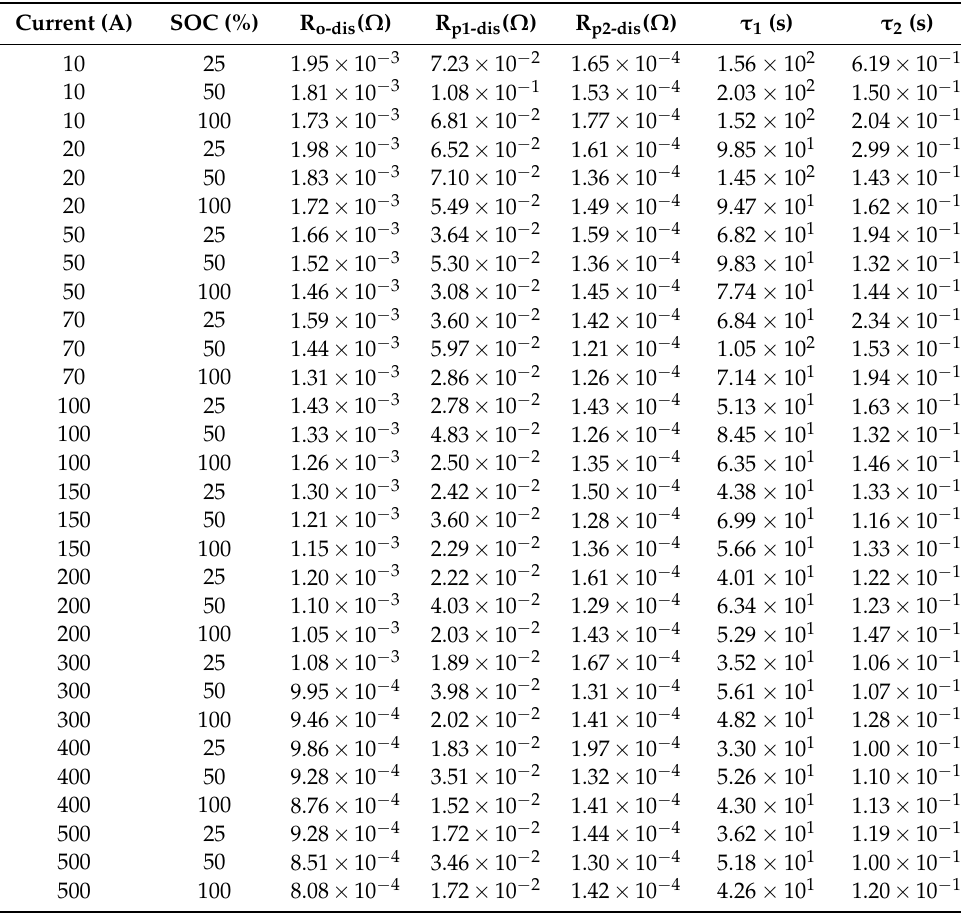
Table 2. The ECM’s estimated electrical parameters at 25 ◦